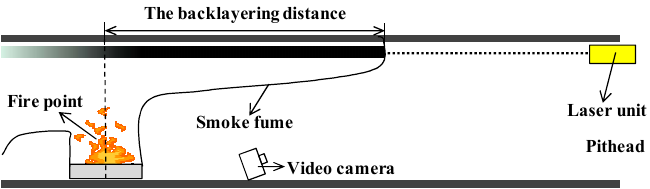
Fig. 4 Measurement of the backlayering distance using the laser beam